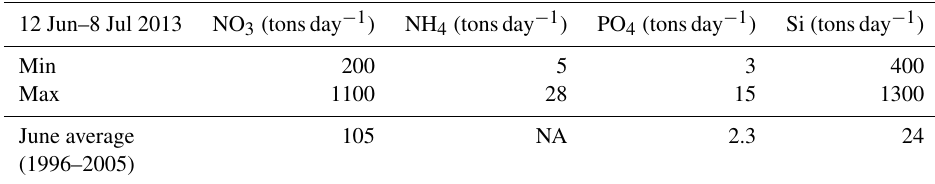
Figure 4. Power spectral density (PSD) plots (gray) of six parameters measured at the Cuxhaven FerryBox station (temperature, salinity, DO, chlorophyll, turbidity and pH). Also shown on each panel in black is the PSD for sea level measured at a station near Cuxhaven. Table 3. Minimum and maximum nutrient loads measured during the elevated discharge in June–July 2013 near Hamburg, Germany. The loads were reproduced with permission from the BSH report (Weigelt-Krenz et al.,